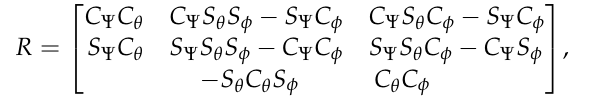
Figure 4. ( a ) Reference system of Quad-copter and ( b ) its movement with respect to the axes. The position of the quad-copter during flight is given by the parameters Roll ( φ ), Pitch ( θ ) and Yaw ( Ψ ) angles, which define its rotation with respect to x-axis, y-axis and z-axis, respectively. The mathematical equation which defines the relationship between the quad-copter with respect to the earth is given